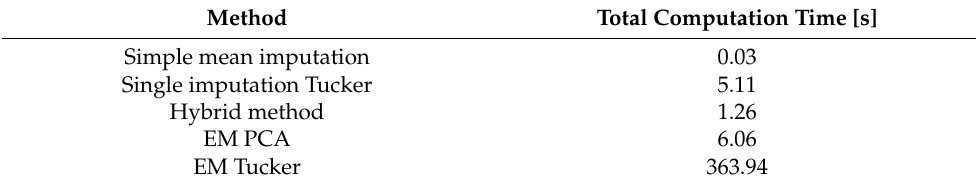
Figure 13. Selected time frames from SPAIN2 (study region 2) are shown across rows (Sierra Nevada mountains appear in light blue (NDVI = 0) in winter in the low-center cell). The first column shows the SPAIN2 frames prior to imputation, where missing values are represented in white. The different imputation methods are shown across the remaining columns. Imputing the missing values, the SPAIN2 tensor was divided into nine equally large 30 × 30 × 66 sub-tensors, and the imputation was conducted on each sub-tensor individually. The blue grid, drawn on top of the each of the frames, shows this division. Table 3. Total computation time for all methods applied to